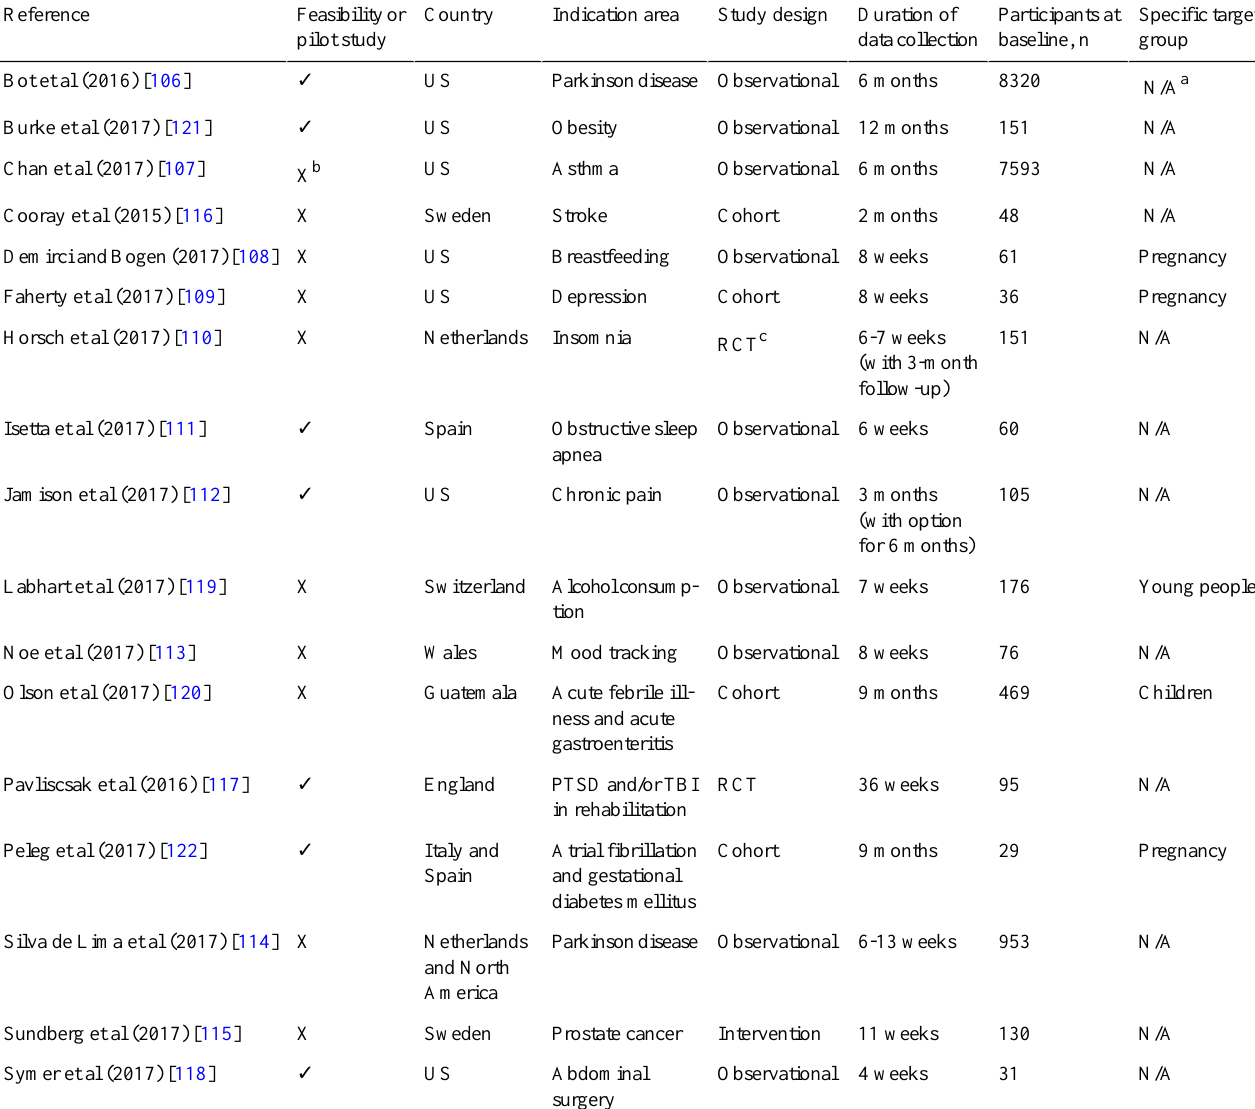
Table 1. Overview of studies included in the scoping